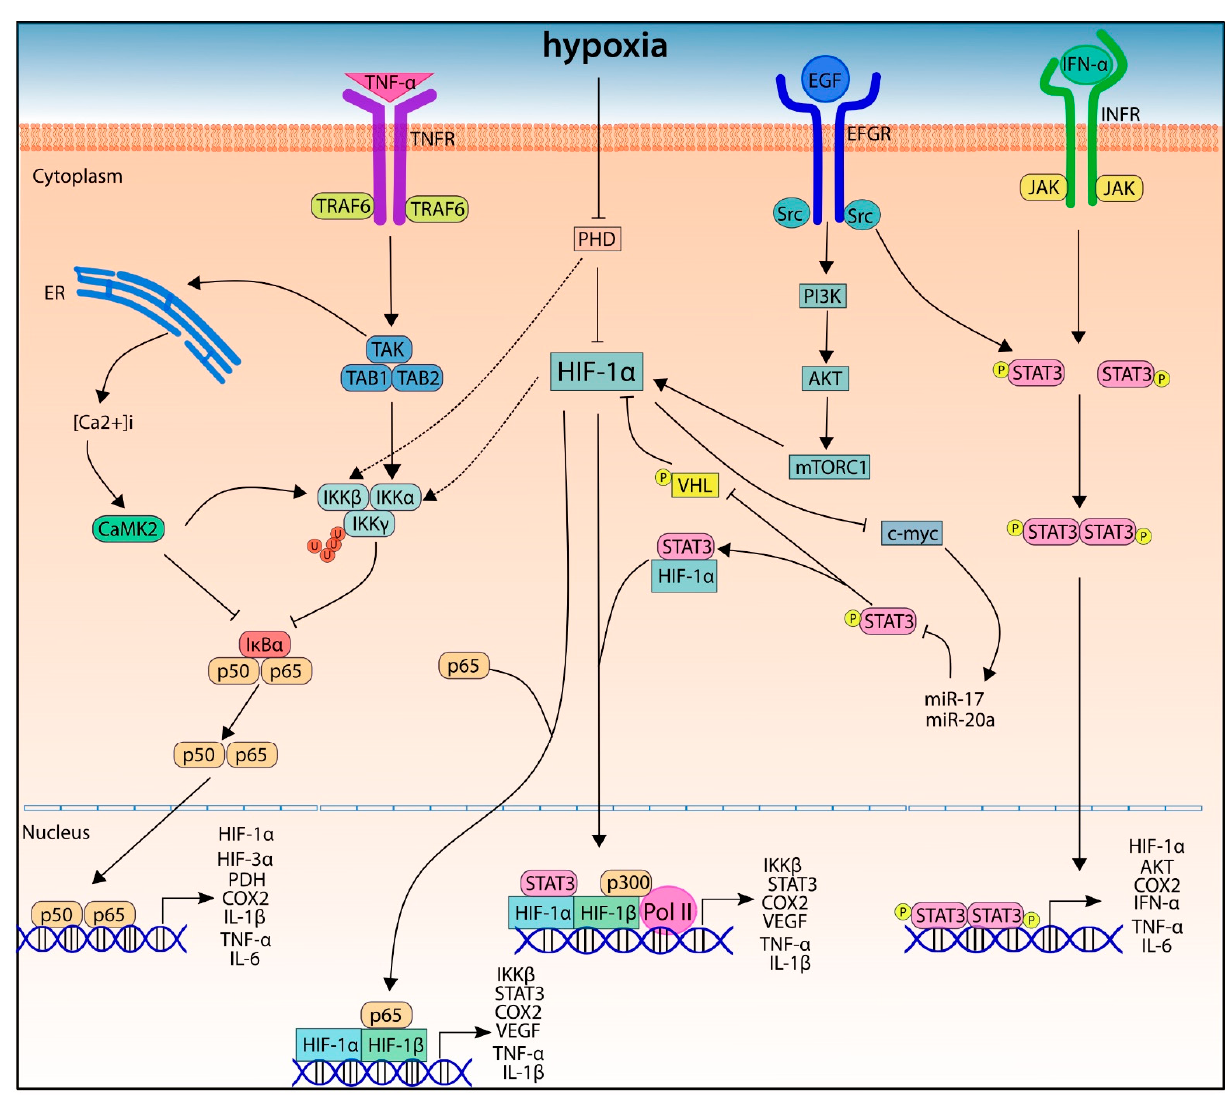
Figure 5. Intercommunication between HIF, NF- κ B, and STAT pathways during hypoxia. Hypoxia induces NF- κ B activity through CaMK2 and the presence of TAK and IKK, leading to the sumoylation of I κ B α . TNF- α also increases HIF-1 α levels through the NF- κ B pathway. Hypoxia through HIF-1 α also induces phosphorylation of the inhibitory I κ B α for its degradation and thus activation of NF- κ B. Moreover, hypoxia inactivates the PHD hydroxylation over IKK β , which conducts IKK β to degradation; instead, IKK β phosphorylates I κ B α to finally activate NF- κ B. STAT3 induces HIF-1 α expression and avoids its degradation, even independently of hypoxia, inducing gene transcription. STAT3 and HIF-1 α interact and recruit coactivators to induce gene transcription, including VEGF. Hypoxia induces the expression of Src, which leads to STAT3 activation and, in consequence, HIF-1 α stabilization. Akt is also activated by STAT3, and as feedback, induces HIF-1 α expression. miR17 and miR20a inhibit differentiation and STAT3 activation. However, HIF-1 α inhibits these miRNAs and avoids their effects (see more details in the main text). are complex. Recently, hypoxia has been related to the induction of pyroptosis through the participation of STAT3 [148]. Pyroptosis is another type of programmed cell death characterized by the participation of gasdermins, a group of proteins that induce the for- mation of pores in the membrane and the release of pro-inflammatory molecules. Gasder- min D (GSDMD) is activated after it is cleaved by caspases 1, 4, 5, and 11, a group of